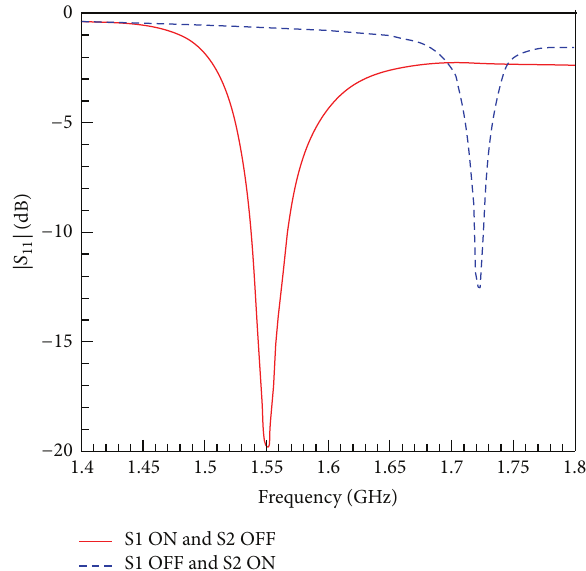
Figure 2: Simulated input impedance mismatch, |𝑆 11 | , as a function of the source frequency of the proposed single NFRP antenna.